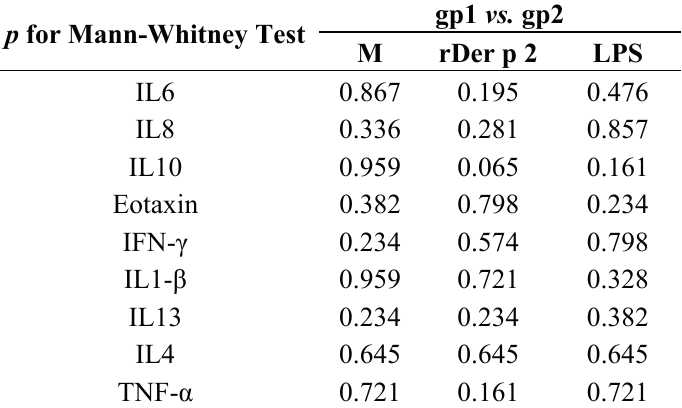
p for Kruskal-Wallis Test; gp1: Patients with genotypes of rs2251746 ( − 95TC) and rs2427827 ( − 344TT/TC) in Fc ε R1 α promoter region; gp2: Patients with genotypes of rs2251746 ( − 95TT) and rs2427827 ( − 344CC) in Fc ε R1 α promoter